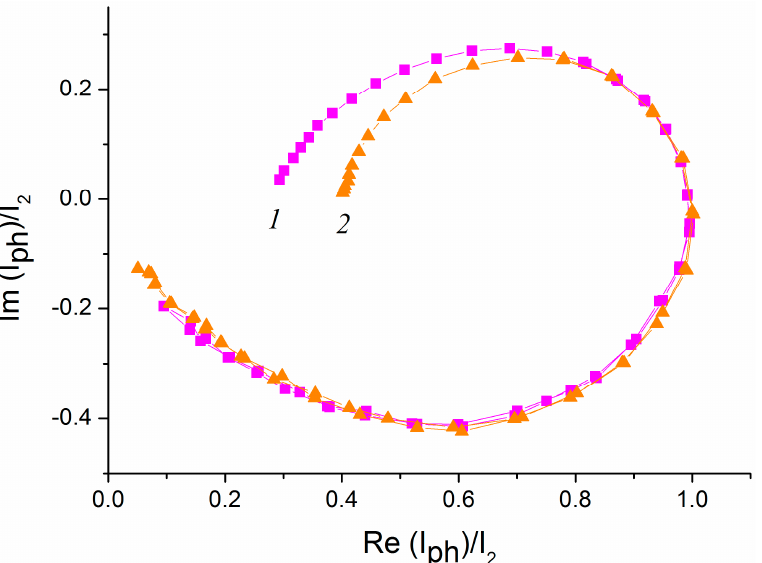
Figure 12. Normalized IMPS spectra for a Ti 4+/ Fe 2 O 3 /FTO film photoanode illuminated with monochromatic light 452 nm at illumination power density 14 mW cm − 2 obtained at a potential of 0.4 V in aqueous solutions of (1) 0.1 M KOH and (2) 0.1 M KOH + 0.01 mM 5,6,7,8-tetrahydro-2-naphthol.